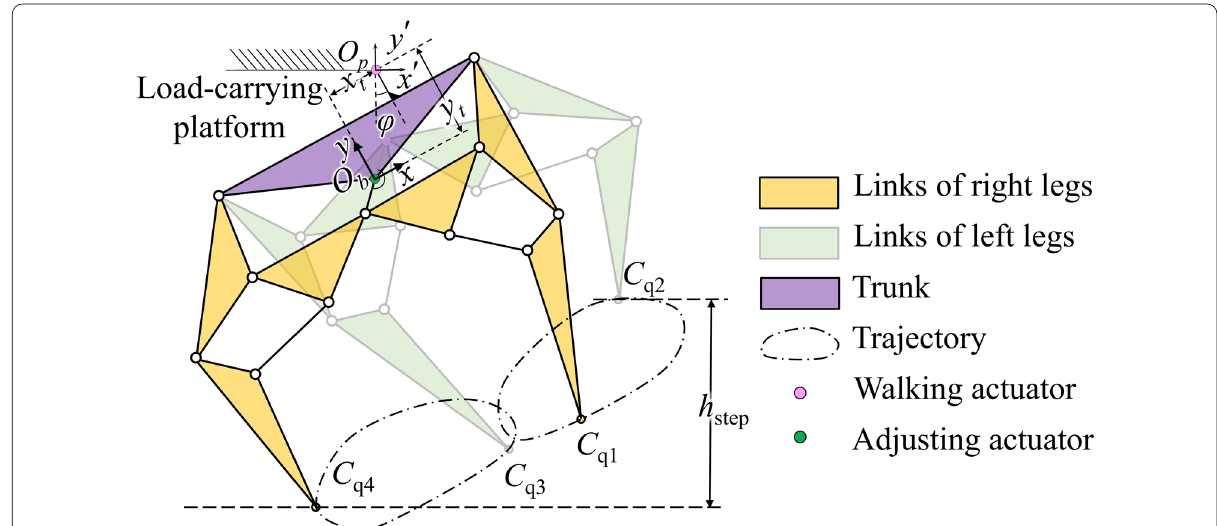
Figure 5 Q‑LUAP